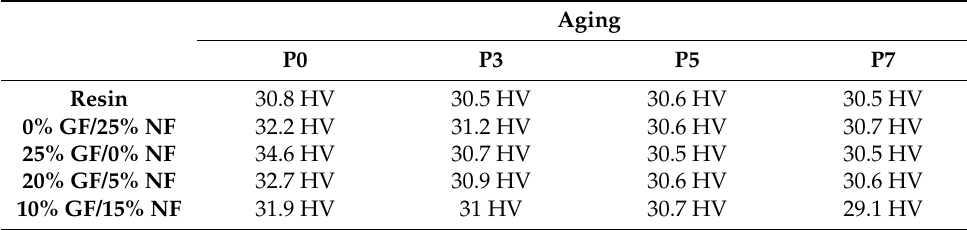
Table 7. Evolution of the Vickers microhardness as function of the solar irradiation period and the fibers loading. Aging P0 P3 P5 P7 Resin 30.8 HV 30.5 HV 30.6 HV 30.5 HV 0% GF/25% NF 32.2 HV 31.2 HV 30.6 HV 30.7 HV 25% GF/0% NF 34.6 HV 30.7 HV 30.5 HV 30.5 HV 32.7